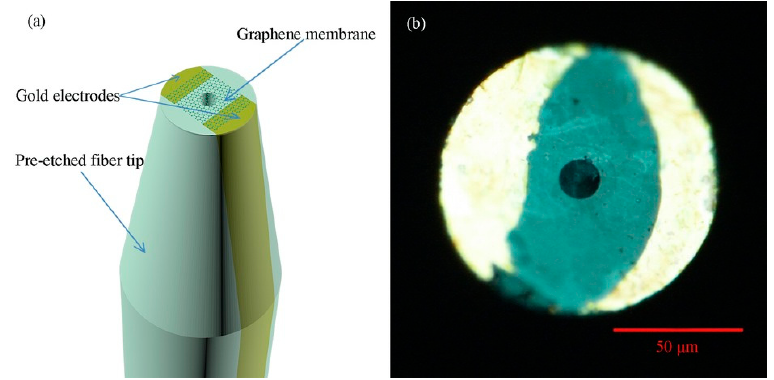
Figure 6. Schematic of ( a ) Pre-etched fiber tip coated with graphene membrane that covers the hole and two gold electrodes and ( b ) optical image of the tip’s end facet [177]. Copyright © 2015, WILEY-VCH Verlag GmbH & Co. KGaA.